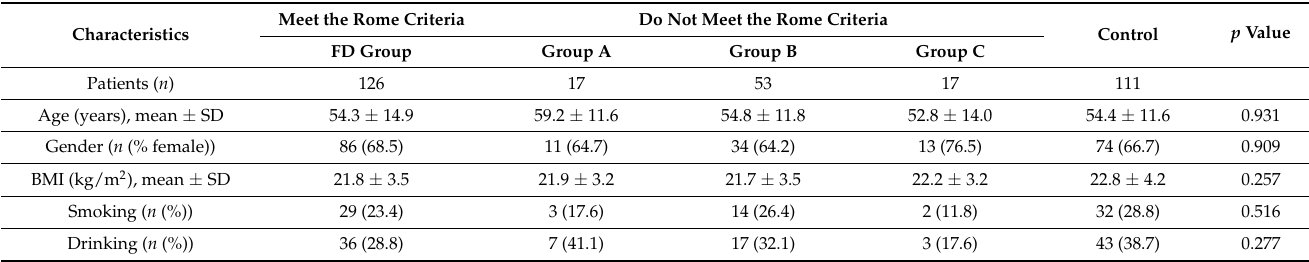
Table 2. Comparison of characteristics among five groups (FD group, Group A, Group B, Group C and control group).